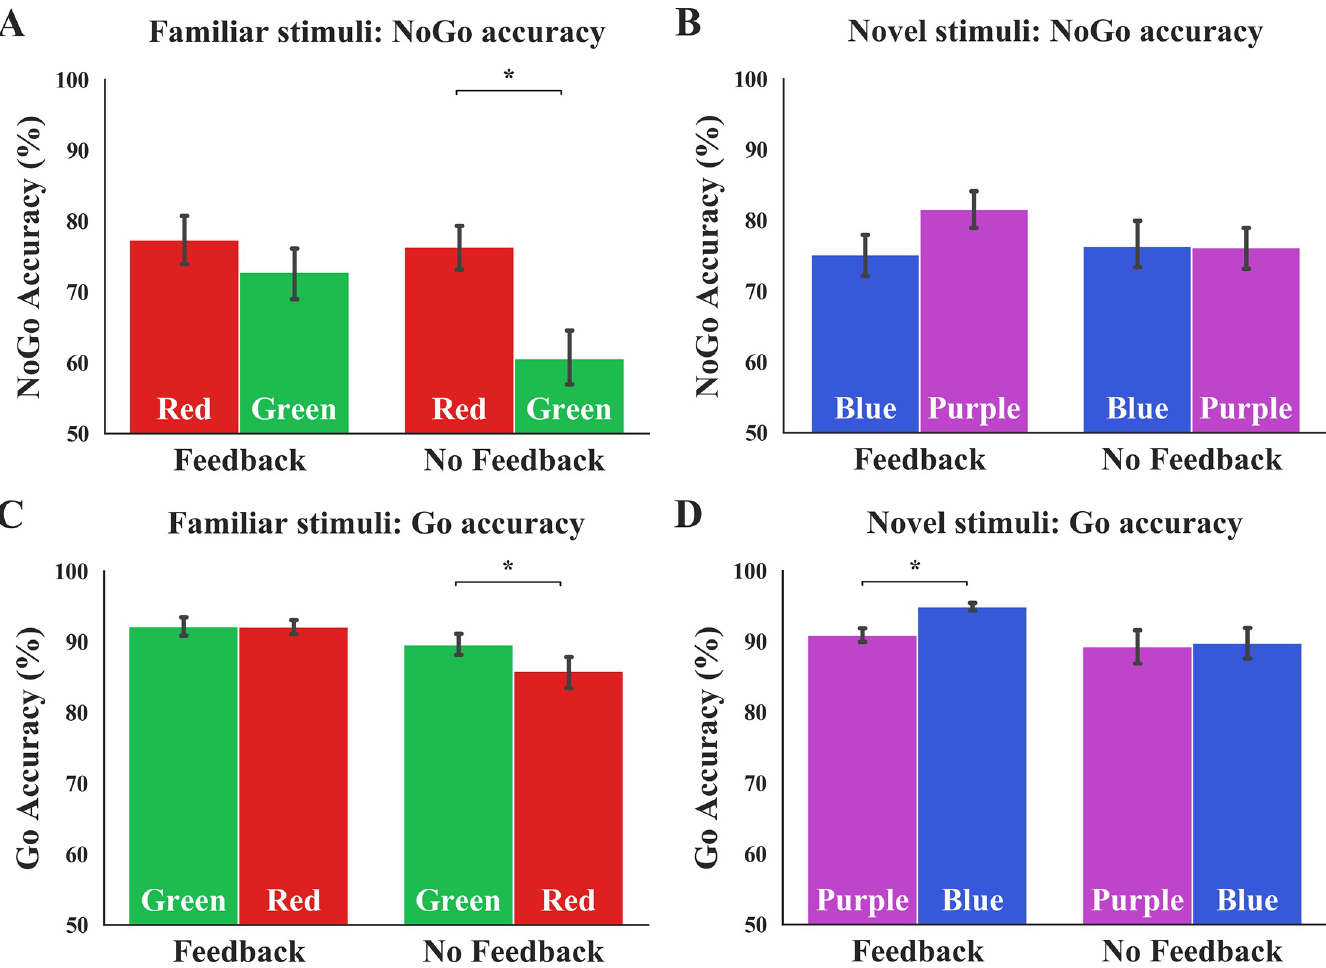
Fig 4. The effects of combined monetary and performance feedback on NoGo and Go accuracy. (A) Monetary and performance feedback disrupt habits while improving goal-directed performance to newly-learned stimuli. Providing performance and monetary feedback protects against the mapping-related change when overriding well-learned associations (Feedback x Color–Response_Mapping interaction: p = .005). (B) The effect of dual feedback on goal-directed control of novel associations fell short of significance (Feedback x Color–Response_Mapping interaction: p = .066, controlling for Gender). (C) Dual feedback improves goal-directed Go accuracy. Dual feedback had a significant effect on mapping-related Go accuracy change when overriding well-learned Go responses (interaction p = .033). (D) Dual feedback improved goal-directed Go responses to novel associations (interaction p = .006). Error bars denote SEM. Color of bars reflects NoGo and Go stimulus colors.